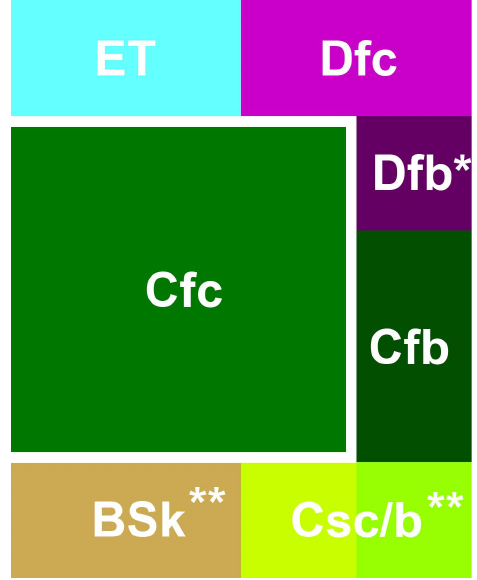
Fig. 1. Cfc Köppen climate type, typical of the coastal regions of modern Iceland, and its neighbouring climate types. Note that plant taxa typical of a Cfc climate commonly occur at least in several fur- ther, adjacent climate types. ( ∗ ) No direct contact, ( ∗∗ ) direct contact only in Southern Hemisphere.